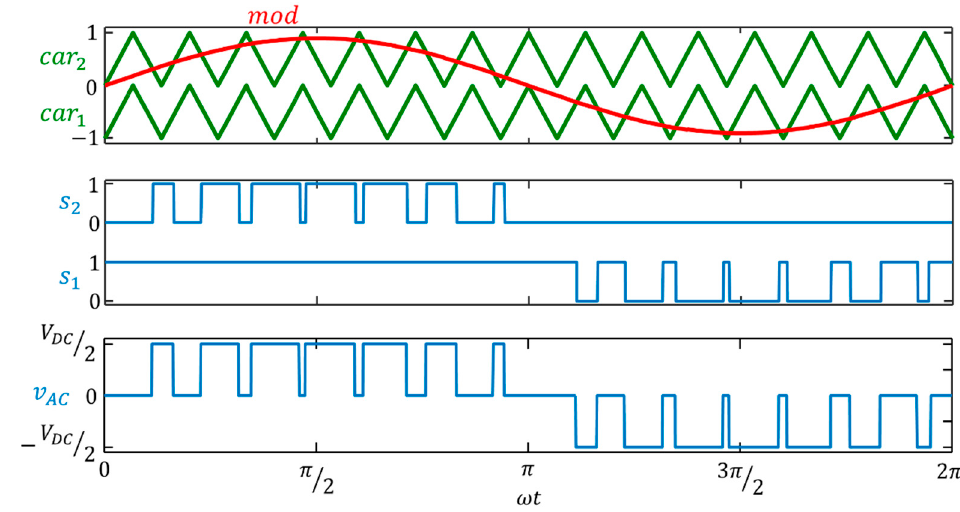
Figure 6. Basic carrier-based PWM strategy in a 3-level converter: per leg modulating and carrier signals, switch control signals, and the resulting leg output AC voltage (modulation index 𝑚 = 0.9 ).